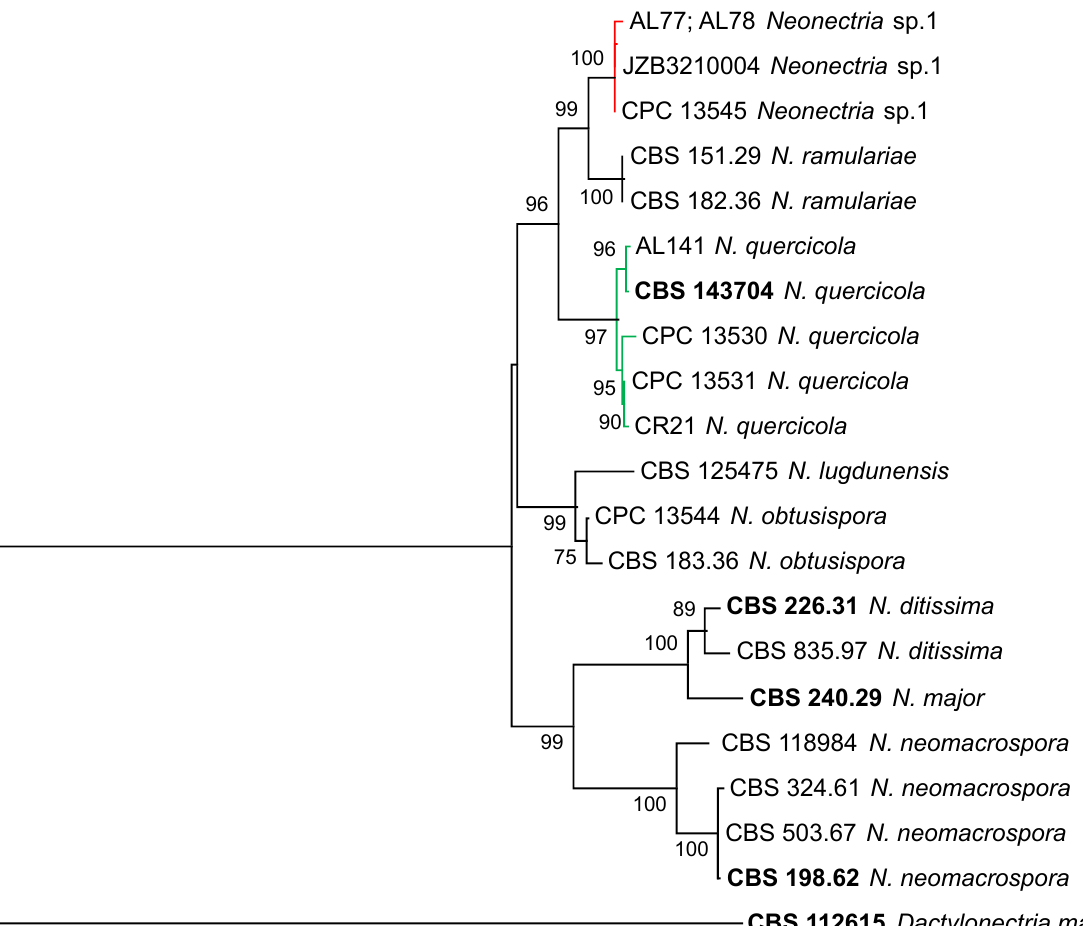
Figure 2. Phylogenetic Maximum Likelihood tree of Neonectria spp. isolated from nursery almond rootstocks and retrieved from the Genbank (ex-type cultures in bold), based on the concatenated partial sequences of ITS, tub2 , his3 and tef1- α (2341 positions) using the Tamura-3 parameter model with a rate of variation across sites (+G). Support for internal branches was assessed by 1000 mL bootstrapped pseudoreplicates of data. Nodes with bootstrap support higher than 70% were indicated in the final tree. The tree with the highest log likelihood is shown. The tree was rooted to Dactylonectria macrodidyma (CBS 112601). The scale bar indicates 0.05 expected changes per site. Evolutionary analyses were conducted in